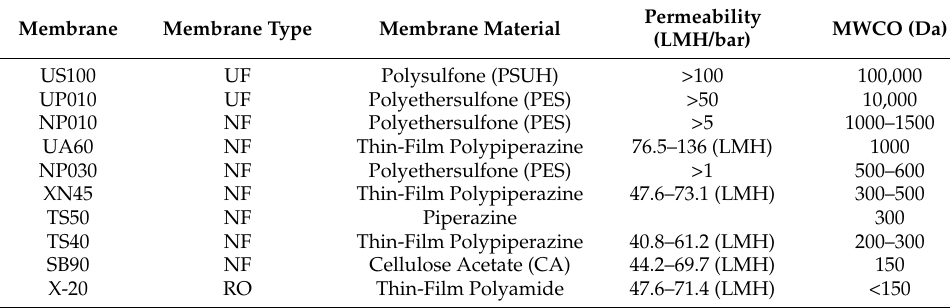
Table 1. Characteristics of membranes used in this